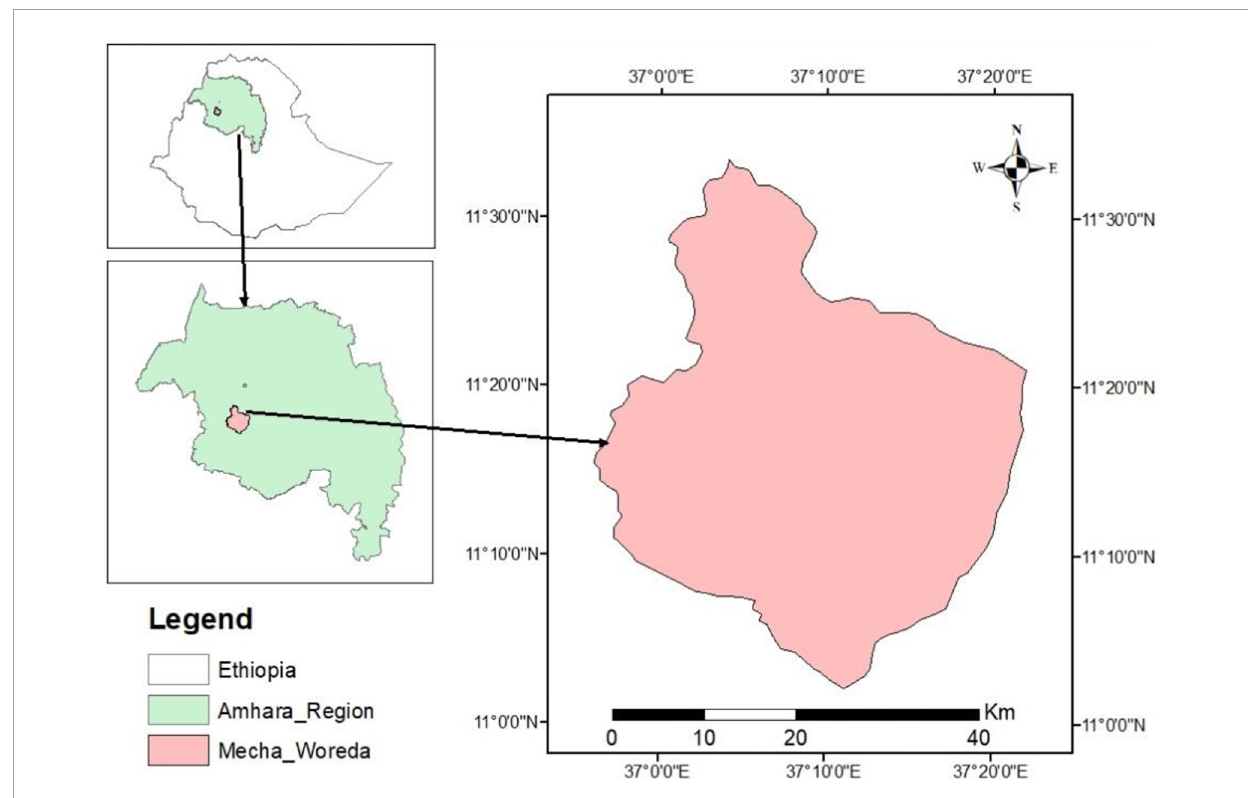
FIGURE1 Map of the study area (source own